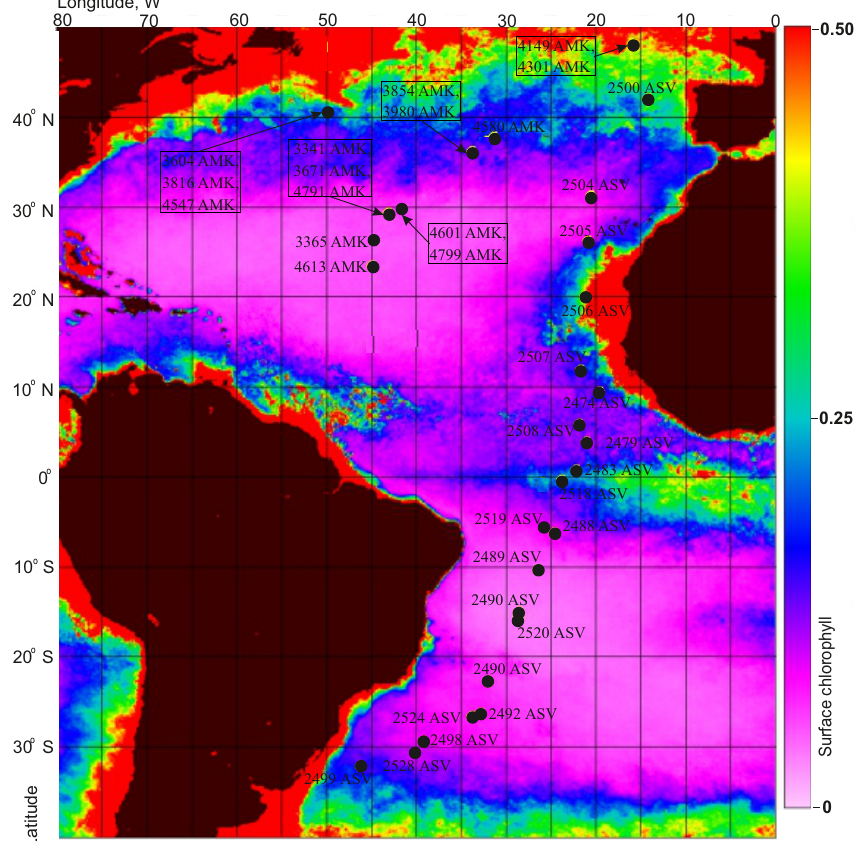
Figure 1. Deep-sea plankton stations (black circles) sampled during the cruises of R/V Akademik Sergey Vavilov (ASV) and R/V Akademik Mstislav Keldysh (AMK) (see also Table 1). Background: surface chlorophyll a concentration averaged over 2013; scale is given (mgm − 2 ) on the